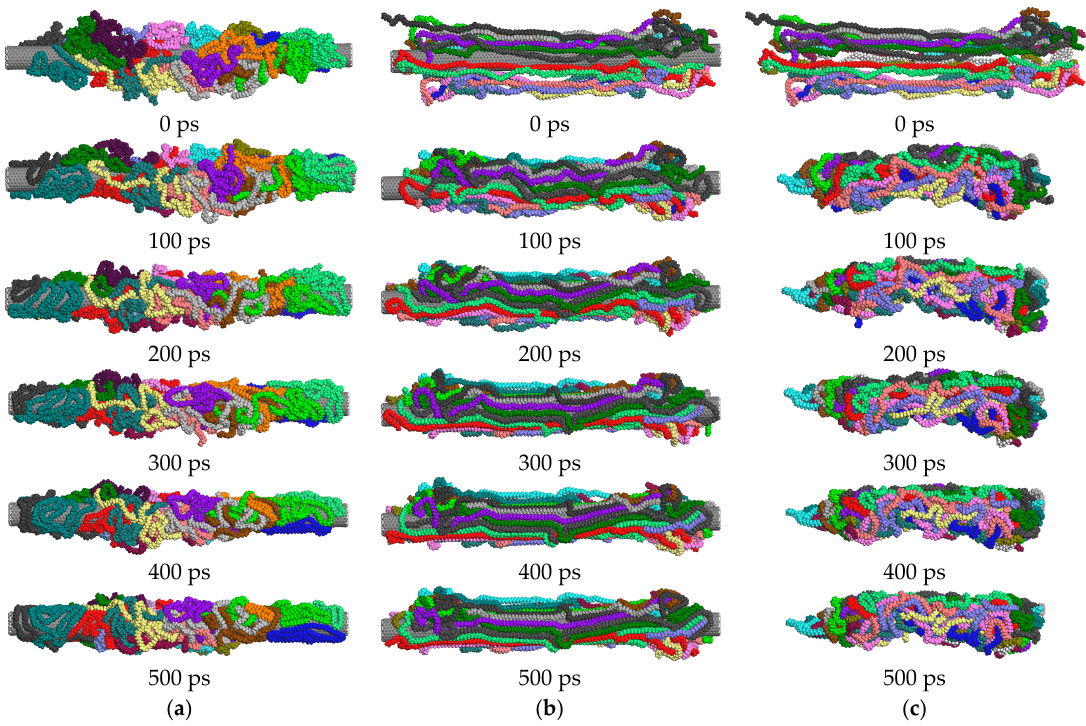
Figure 4. The conformation evolution process of polyethylene (PE) molecular chains. ( a ) The static composite system; ( b ) The sheared composite system; ( c ) The sheared pure PE system.